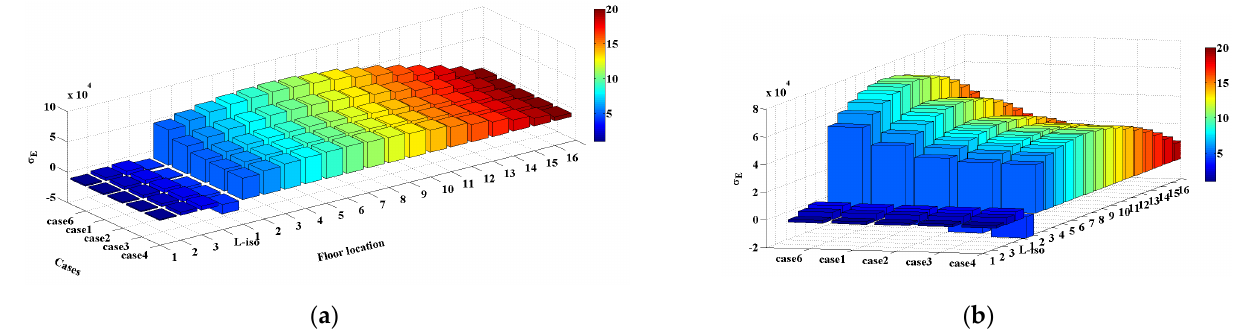
Figure 18. Energy distribution map of layer position under different control schemes: ( a ) a three- dimensional view from one angle; ( b ) a three-dimensional view from another angle .